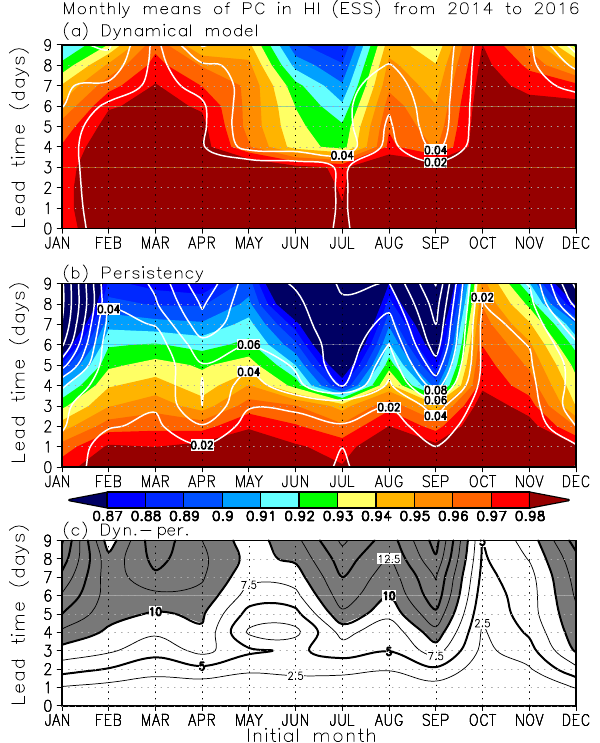
Figure 6. The prediction accuracy (PCC) of the SIT forecast in the ESS (70–80 ◦ N, 150–180 ◦ E) in each month obtained from (a) an operational forecast model and (b) persistency of the initial value, averaged from 2014 to 2016. The standard deviations of the PCCs are shown with white contours. In panel (c) , the fraction of variance explained by operational forecast relative to the persistency (%) is shown by the contour (the region where the fraction is larger than 10% is